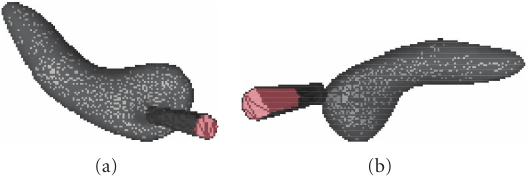
Figure 6: Gallbladder deformation generated by surgical simulator: (a) and (b) are distortions caused when the endoscope pokes and grasps the gallbladder.